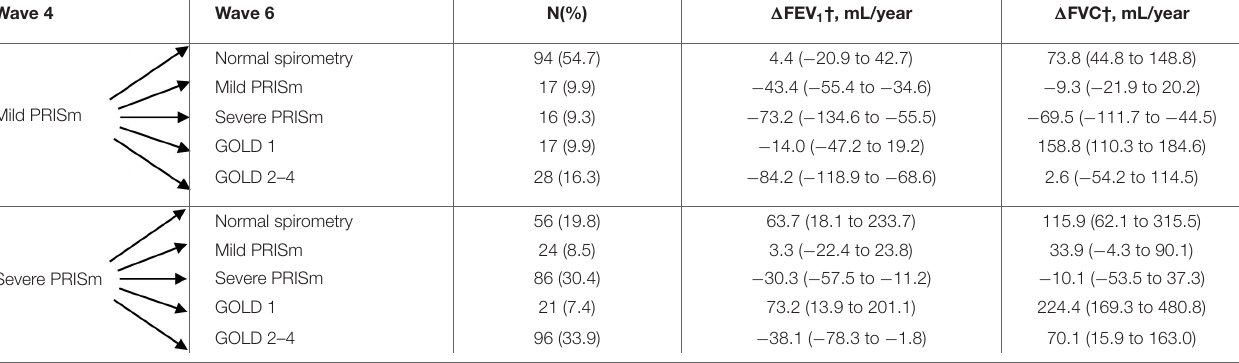
TABLE 4 | Changes of lung function categories, FEV 1 , and FVC among subjects with mild PRISm and severe PRISm from Wave 4 to Wave